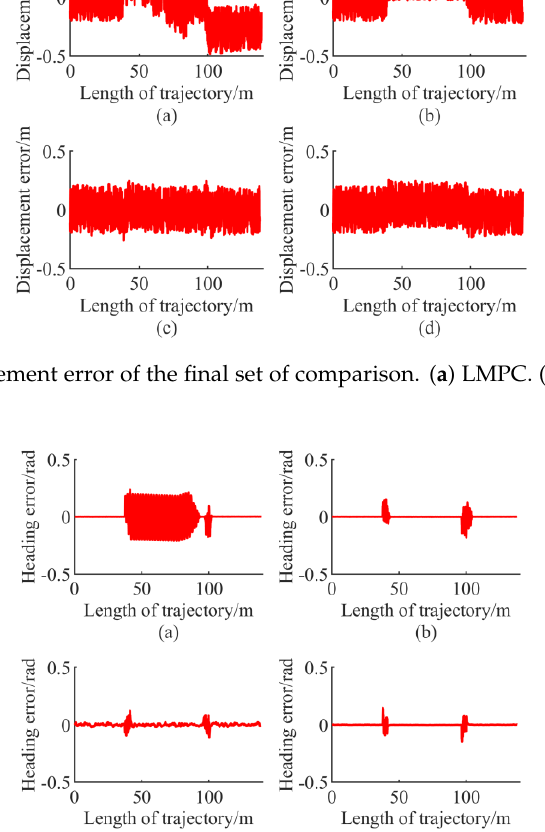
Figure 43. The heading error of the final set of comparison. ( a ) LMPC. ( b ) LEMPC. ( c ) NMPC. ( d ) NEMPC.